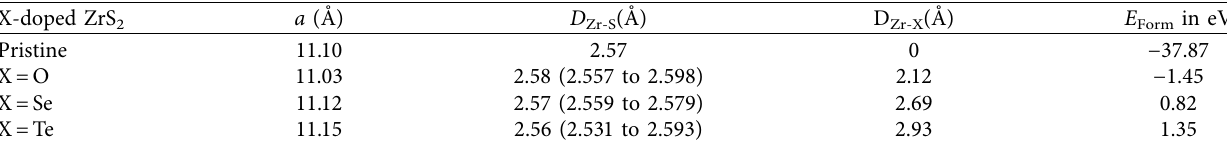
Table 1: Structural parameters (lattice constants ( a ), the average bond length between Zr and the nearest S atoms ( D between nearest Zr and the X atom ( D Zr-X ), and the formation energy ( E Form )) of the pristine and single-doped ZrS 2